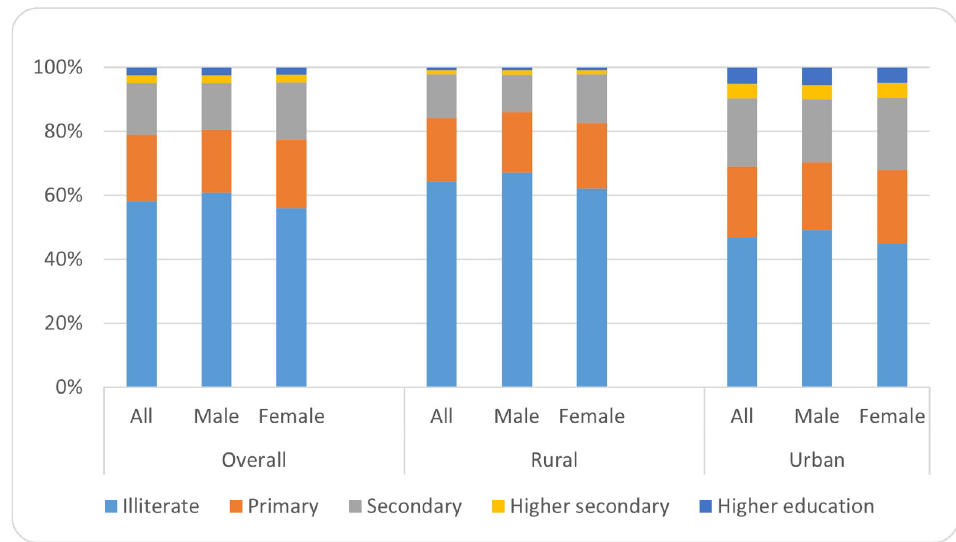
Fig 2. Educational attainment of fathers by location and gender of the